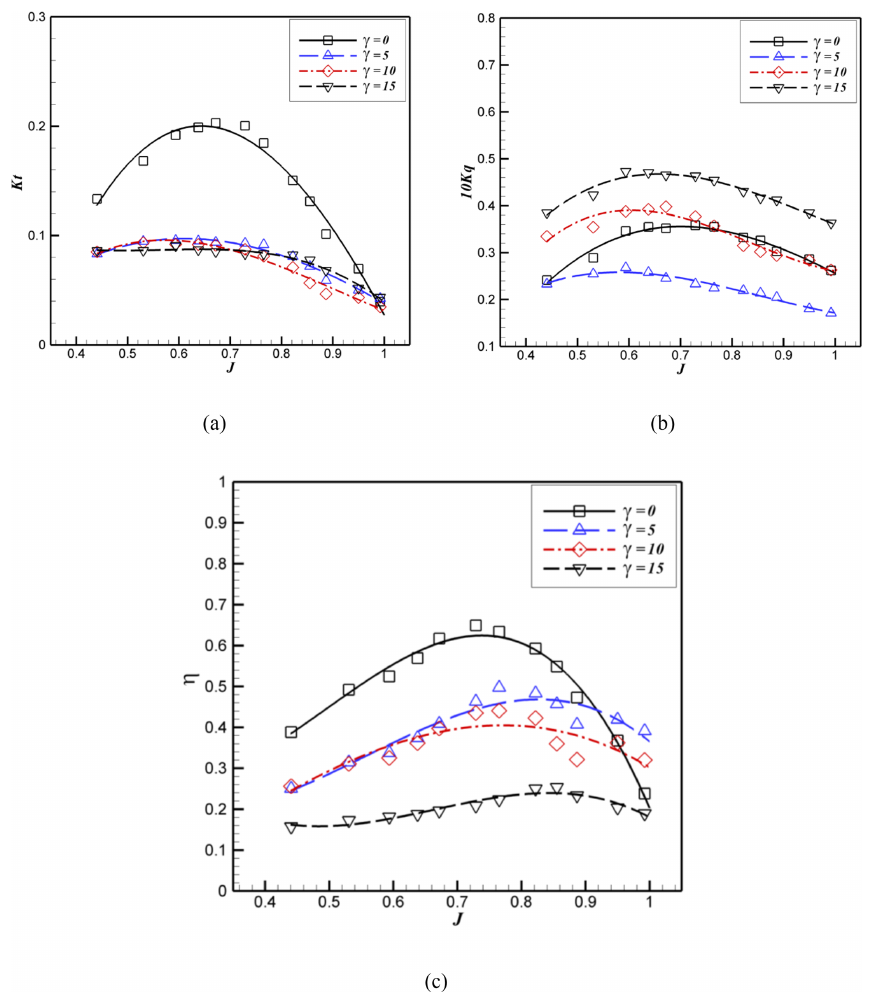
Figure 14. Effect of the shaft inclination angle on the hydrodynamic coefficients and efficiency of the surface-piercing propeller at 33% immersion